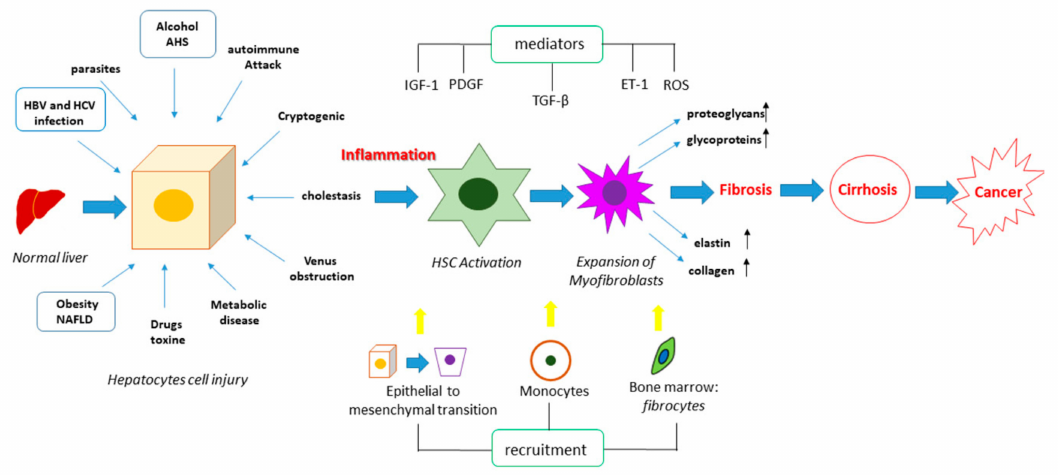
Figure 1. Normal and fibrotic liver architecture. ( A ) In the healthy liver the hepatocytes are closely joined by gap junctions. The liver sinusoid, a large fenestrated capillary, is mainly constituted by sinusoidal endothelial cells (SECs), Kup ff er cells, specialized hepatic macrophages, and the Pit cells, the natural killer lymphocytes of the liver. The space between the hepatocytes and the sinusoid, called “the space of Disse”, hosts the hepatic stellate cells (HSCs); ( B ) following HSCs activation, there is a massive accumulation of extracellular matrix (ECM) as well as the loss of microvilli in the hepatocytes and the loss of fenestrae in SECs; ( C ) stages of hepatic fibrosis.